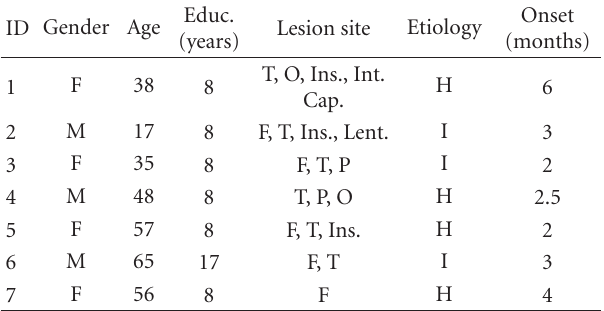
Table 1: Demographical and clinical data of right brain damaged